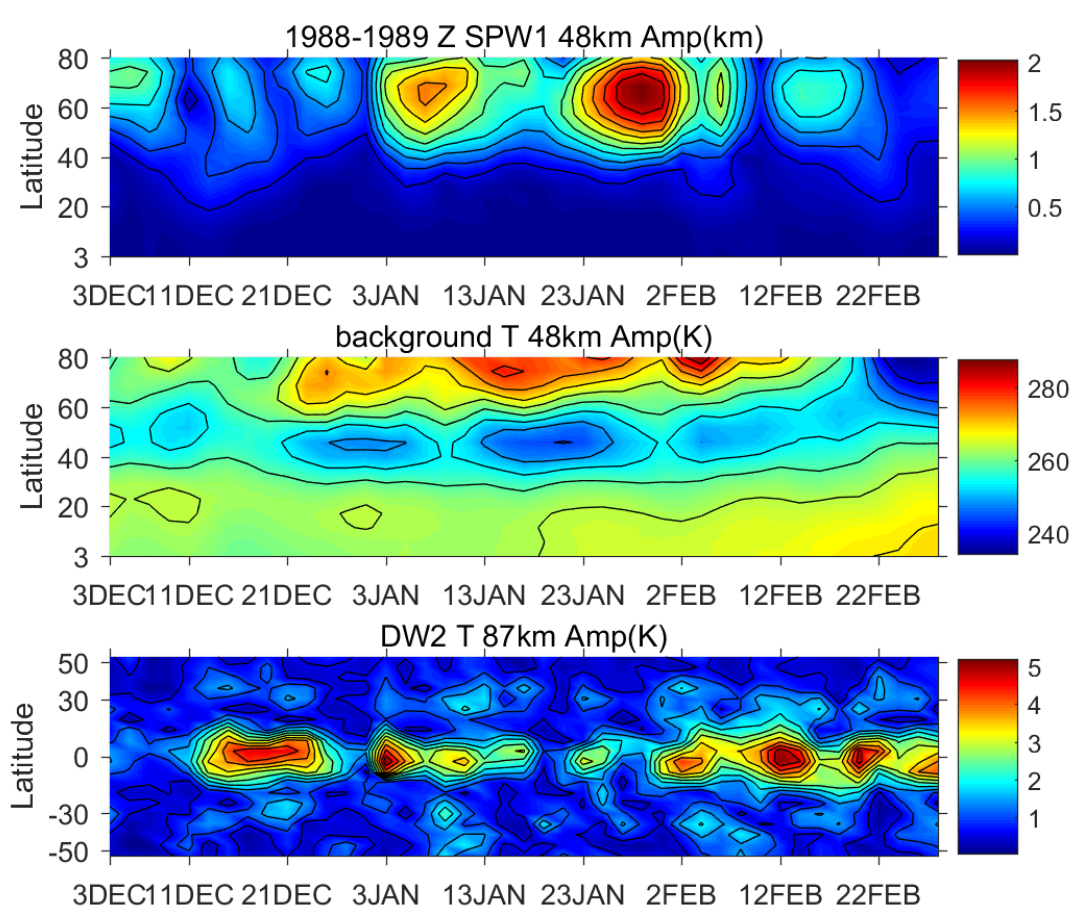
Figure 7. Same as Figure 1, but for the winter of 1988–1989: The lowest correlation between SPW1 and DW2.